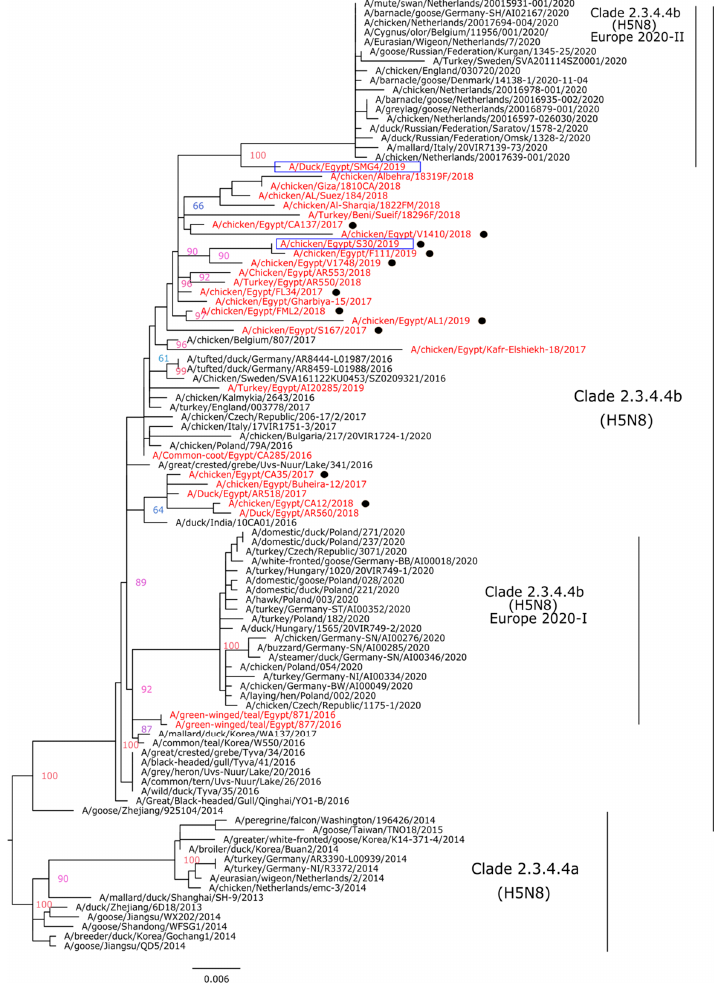
Figure 3. Phylogenetic tree of the NA gene segment of HPAI H5N8 viruses. A phylogenetic tree including a total of 99 NA segments from different H5N8 viruses was obtained using the IQTree software after selection of best fit model (K3Pu + F + G4). Egyptian HPAI H5N8 viruses are colored in red; viruses of the current study ( n = 11) are indicated with black dots. The two Egyptian HPAI H5N8 viruses selected for IVPI are in blue boxes.